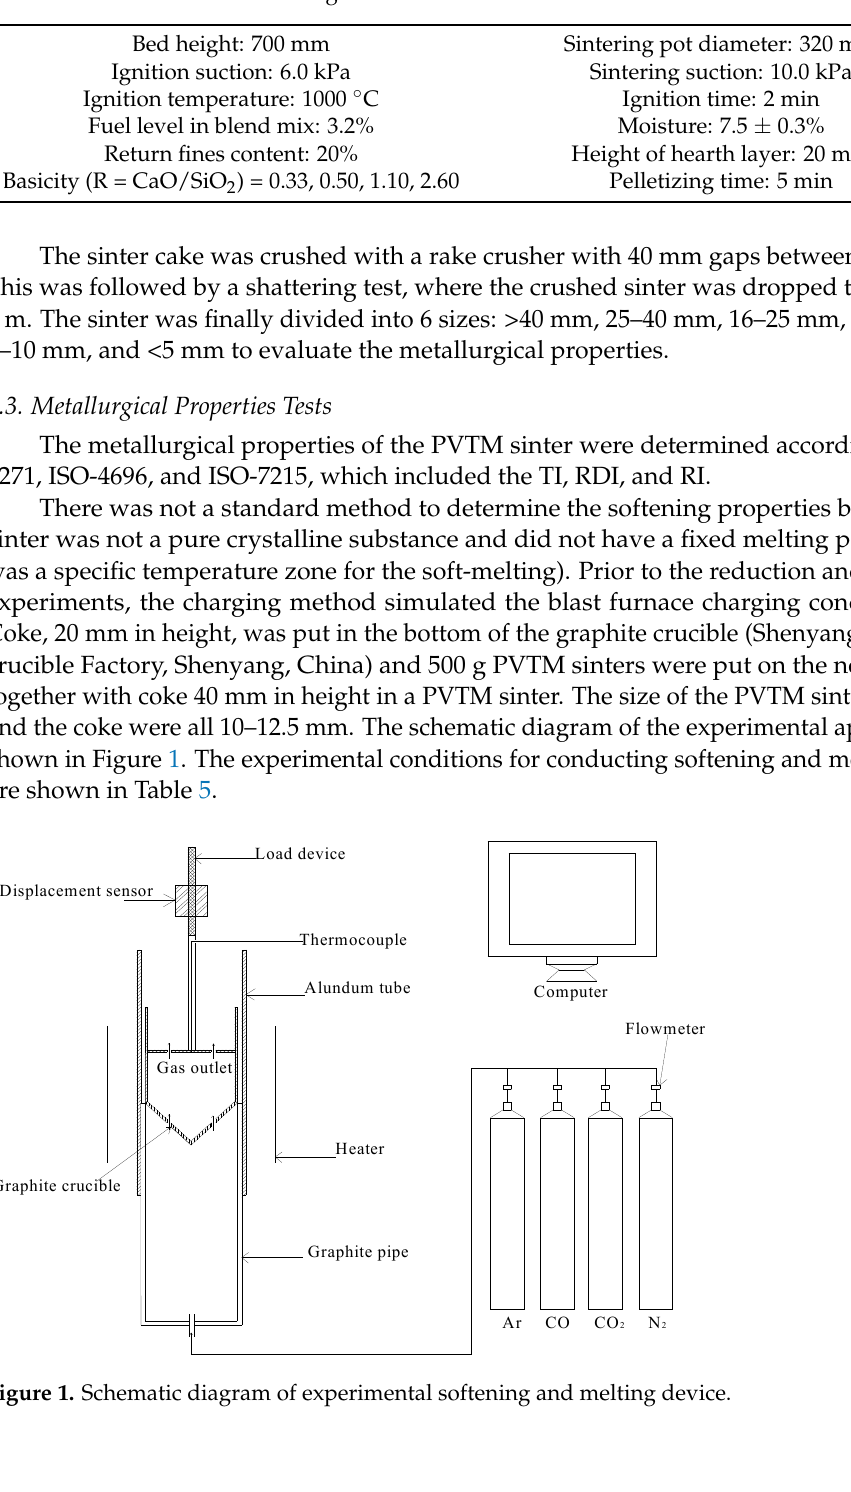
Table 4. Parameters of the sintering test.